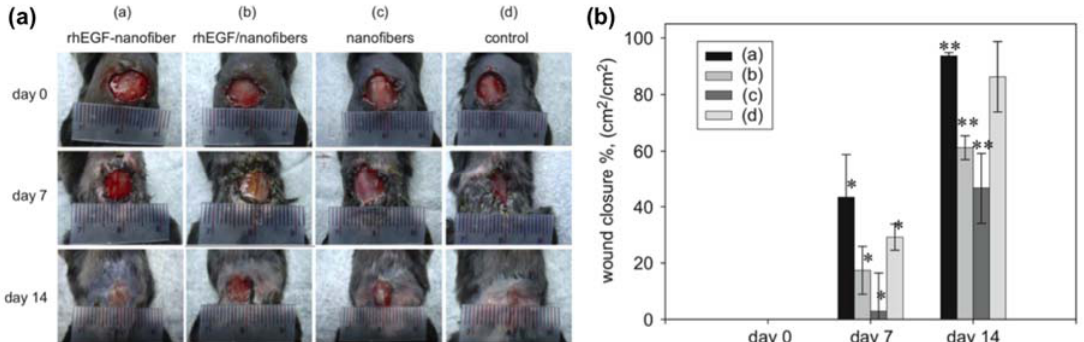
Figure 4. ( a ) In vivo evaluation of wound healing using a mouse model for comparison of epidermal growth factor ‐ immobilized nanofibers with blank nanofibers and controls. ( b ) Quantitative analysis of wound ‐ closure rates in the diabetic mice for epidermal growth factor ‐ immobilized nanofibers with blank nanofibers and controls. * and ** indicate statistical significances p < 0.05. Reproduced with permission from [147].